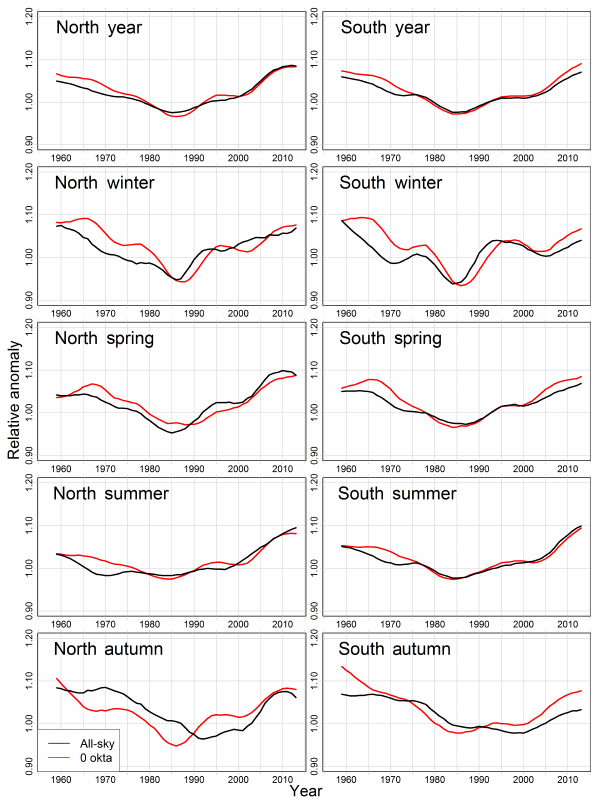
Figure 8. All-sky (black lines) and clear-sky 0okta (red lines) SSR annual and seasonal low-pass filter for northern (left column) and southern (right column) Italy. The filters are the same as in Figs. 4 and